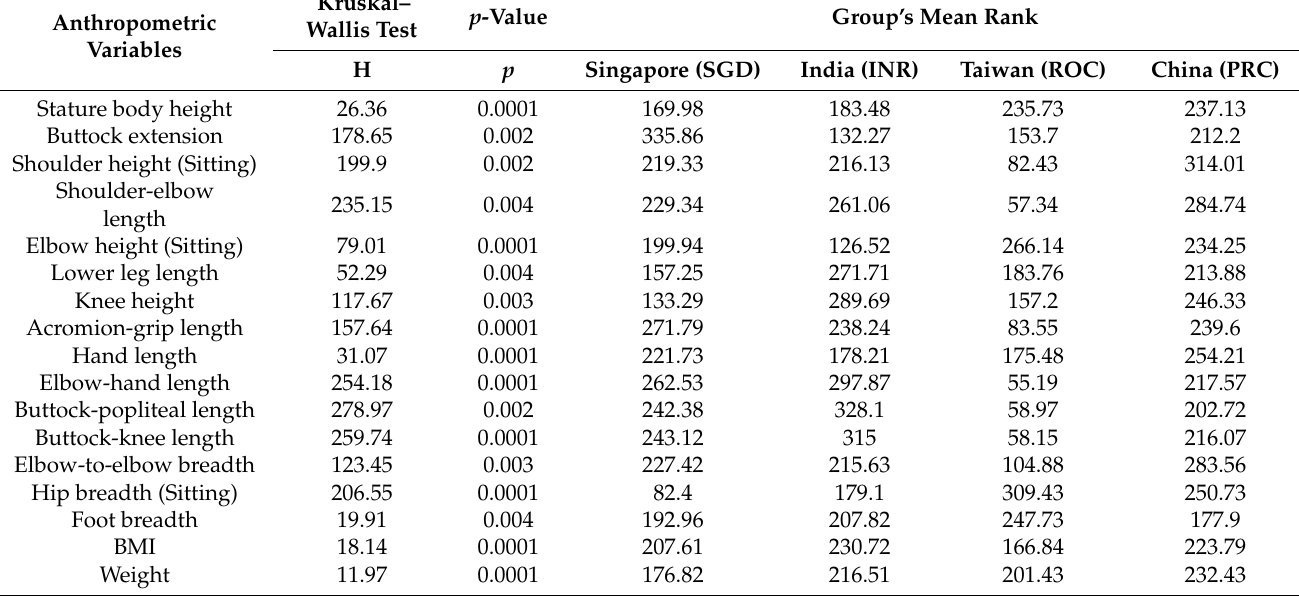
Table 3. Results of the Kruskal–Wallis